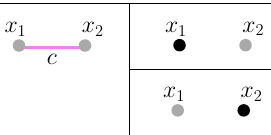
Figure 6: The network K 2 (left) and the collection of 2 -rooted forests for K 2